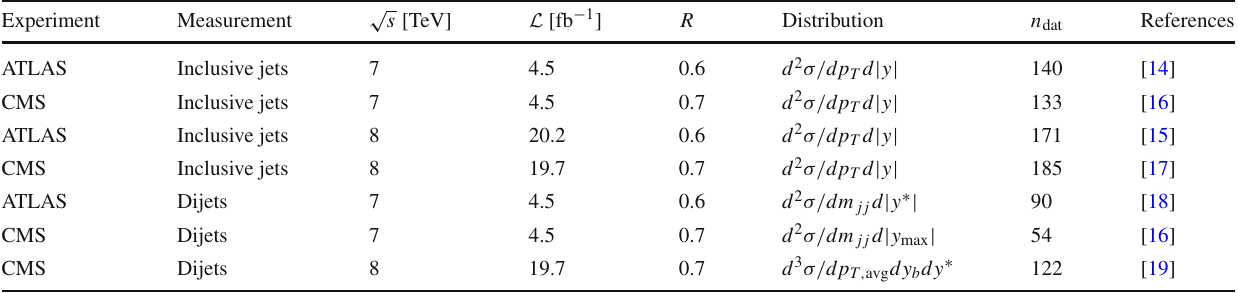
jet radius R , the measured distribution, the number of datapoints n dat and the reference √ s , the luminosity L , the √ s [TeV] L [fb − 1 ]